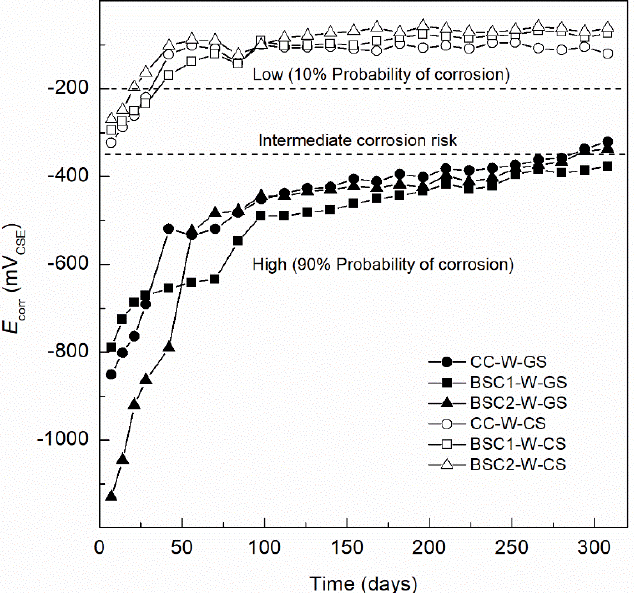
Figure 4. E corr monitoring of GS and CS reinforced concrete exposed to control medium